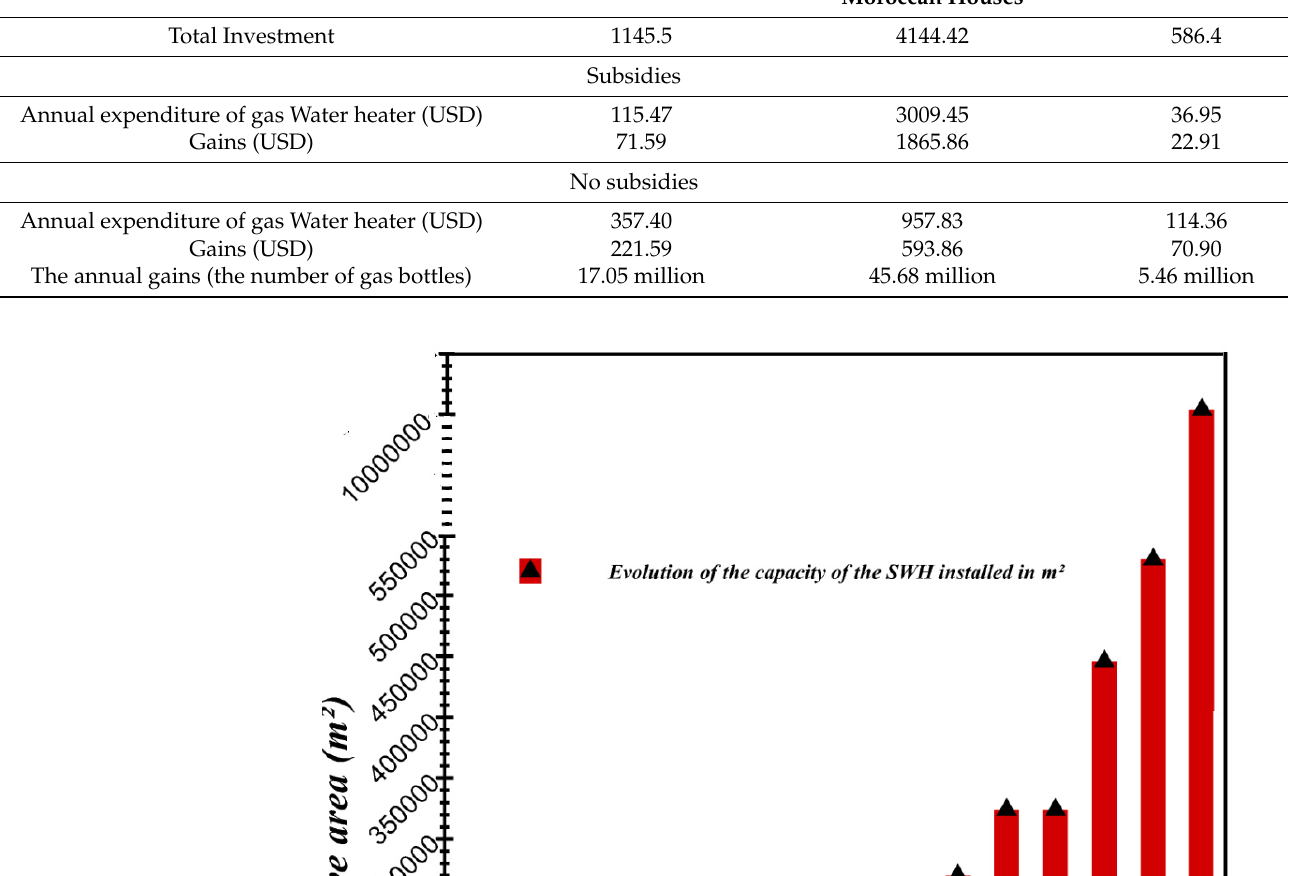
Table 9. The total gains for different type of houses according to the two scenarios (with and without subsidies). Type of House